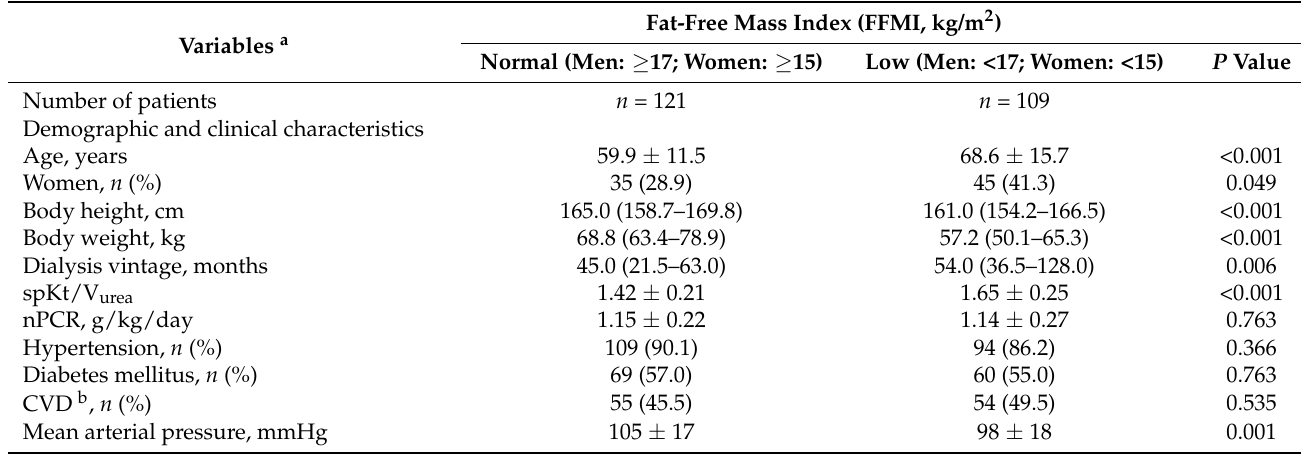
Table 1. Baseline characteristics of hemodialysis patients with and without decreased lean body